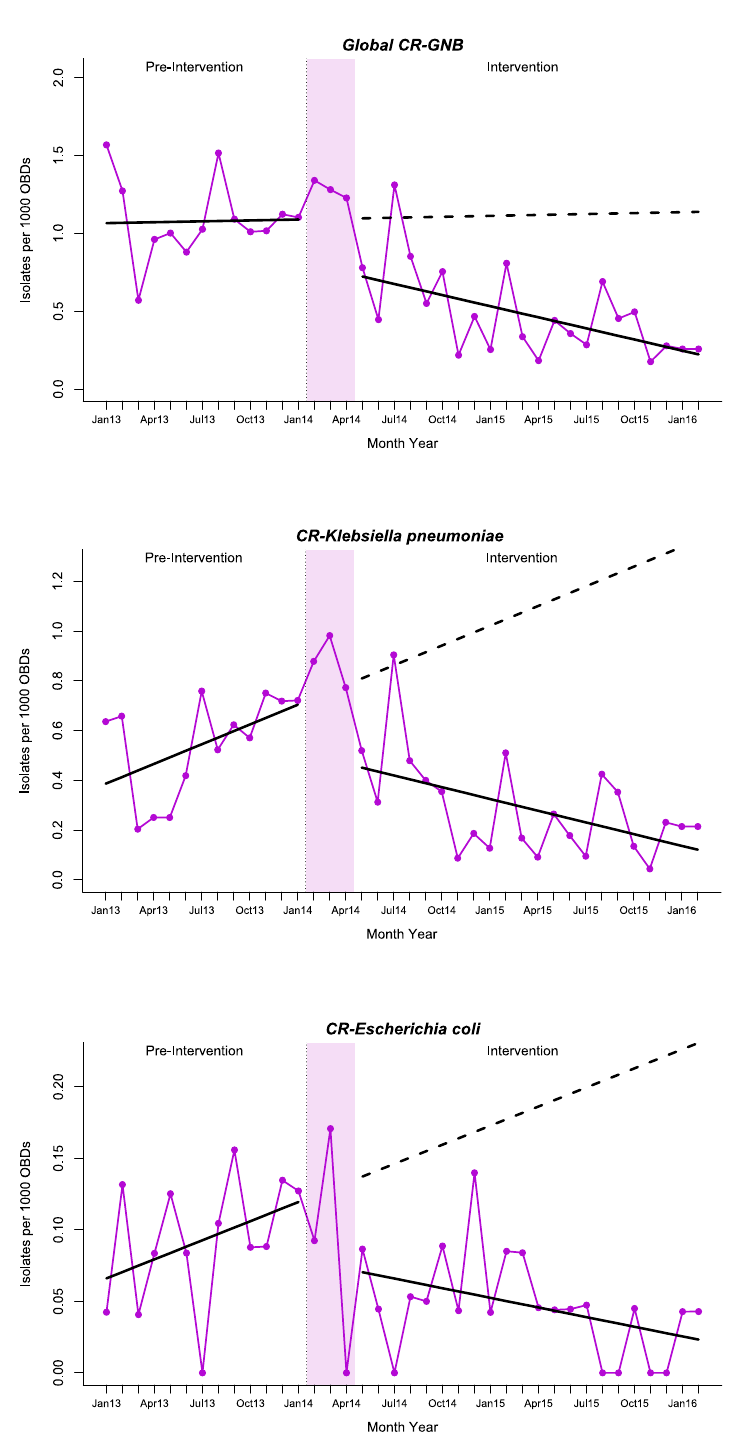
Figure 2. Interrupted time series analysis of changes in trends of incidence density of global carbapenem-resistant Gram-negative bacilli (CR-GNB), CR- K. pneumoniae and CR- E. coli observed before and after the intervention. Solid purple line: incidence density of CR-GNB time series. Solid black lines: observed trend during the pre-intervention and intervention periods. Dashed black line: counterfactual (expected) trend after the intervention according to the pre-intervention values. OBDs: occupied bed days.